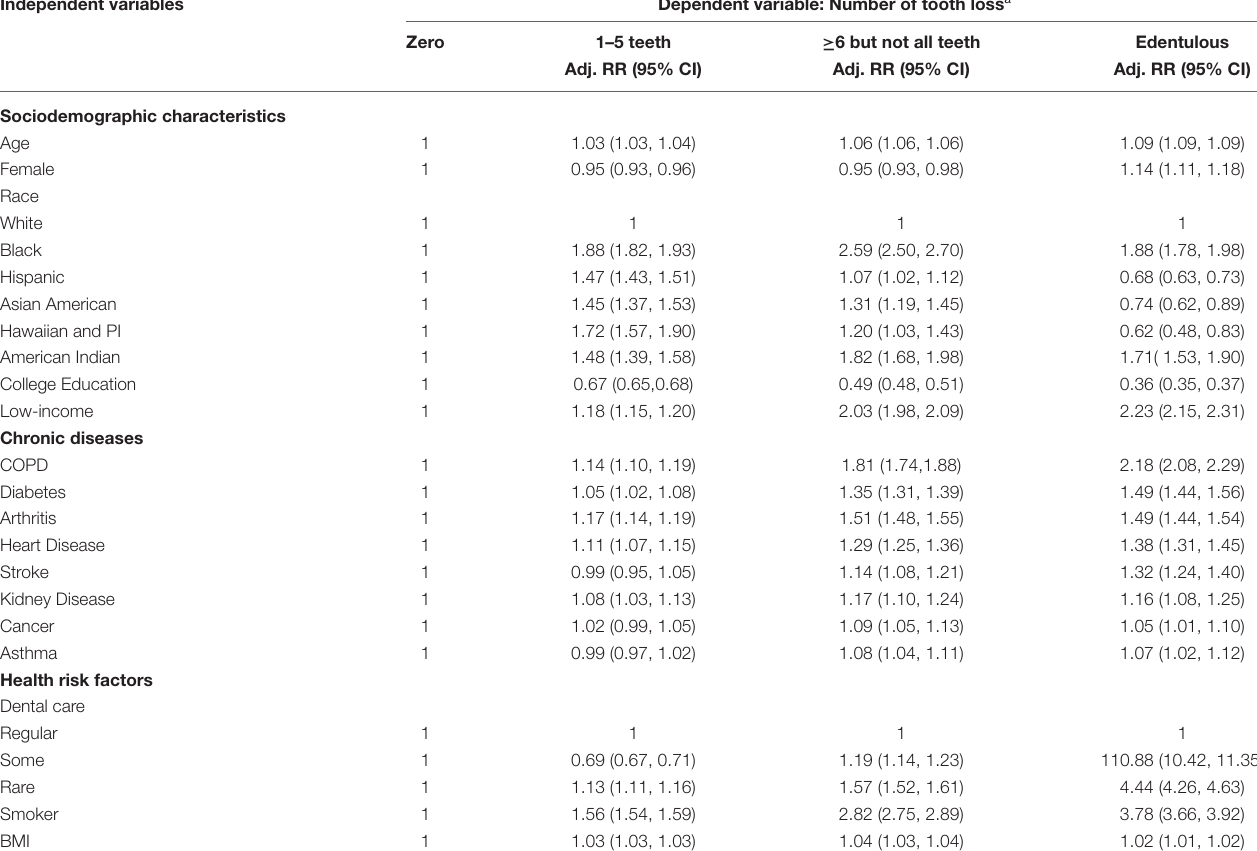
TABLE 3 | Factors associated with tooth loss, US adults, BRFSS, 2012. Independent variables